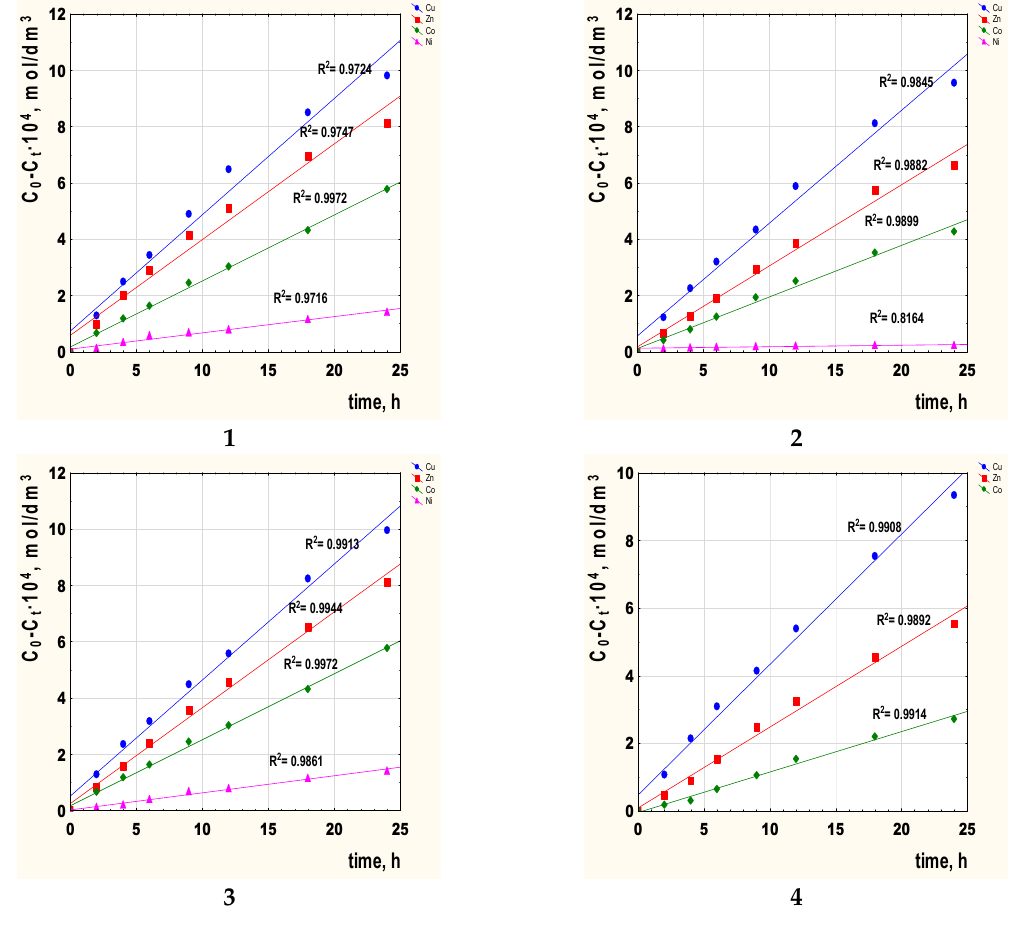
Figure 5. The relationship C 0 -C t vs. time of metal ions transport across PIMs with 2-alkylimidazole 1 – 4 as the carrier; 2-methylimidazole ( 1 ), 2-ethylimidazole ( 2 ), 2-propylimidazole ( 3 ), and 2- butylimidazole ( 4 ).